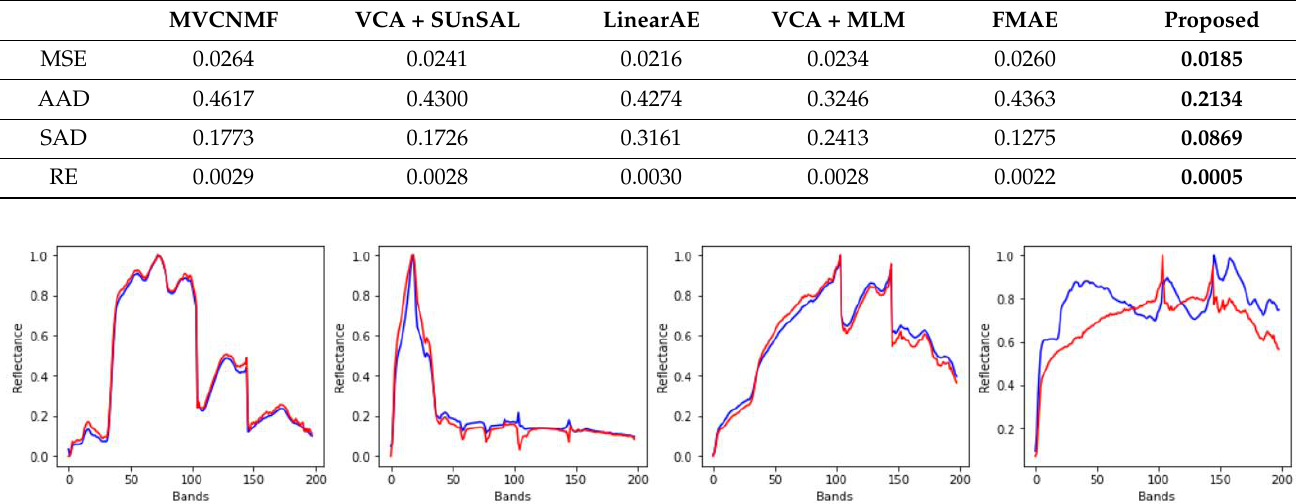
Figure 7. False-color image of ( a ) Jasper Ridge, ( b ) Urban. Table 4. Comparison of different methods on Jasper Ridge. Best results are reported in bold.